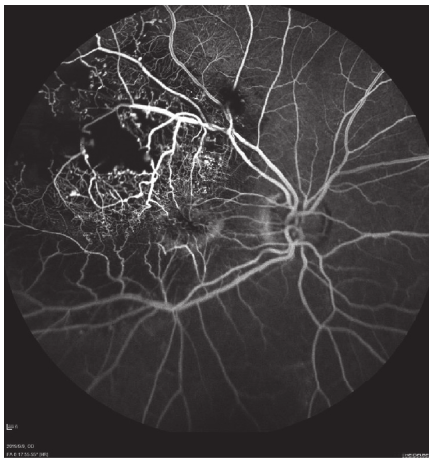
Figure 2: Fluorescein angiographic image of a 40-year-old male patient (Case 4) in the DEX (+) group. The figure shows the right eye diagnosed with Coats’ disease classified as Stage 3A. The baseline visual acuity of this patient was FC/30cm. Parafoveal and temporal retinal telangiectasia, aneurysmal vascular channels, and large area of capillary nonperfusion in the temporal retina can be observed at this early-phase fluorescein angiographic